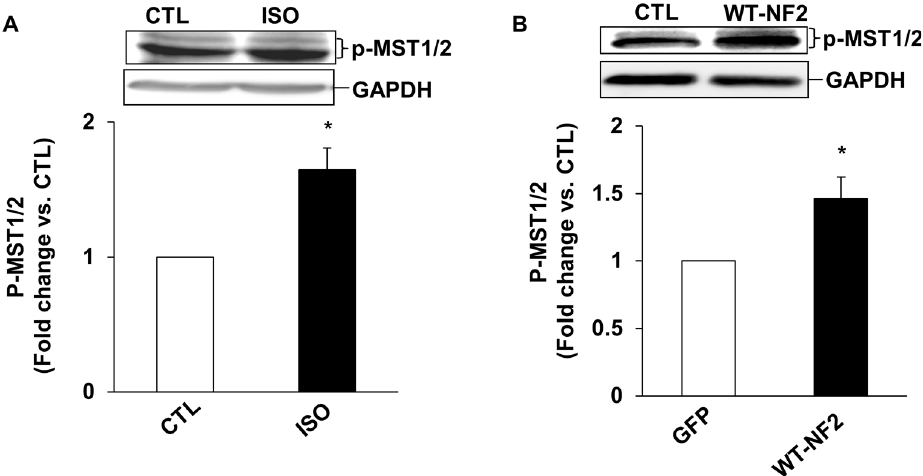
Fig 5. β -AR stimulation and adenoviral-mediated expression of NF2 increase phosphorylation of MST1/2 in ARVMs. ARVMs were treated with ISO for 15 min (A) or infected with adenoviruses expressing WT-NF2 or GFP for 48 h (B). Total cell lysates were analyzed by western blot using phosho-specific anti-MST1/2 antibodies. The lower panels exhibit the mean data normalized to GAPDH, (cid:3) p < 0.05 vs CTL or GFP; n = 5.